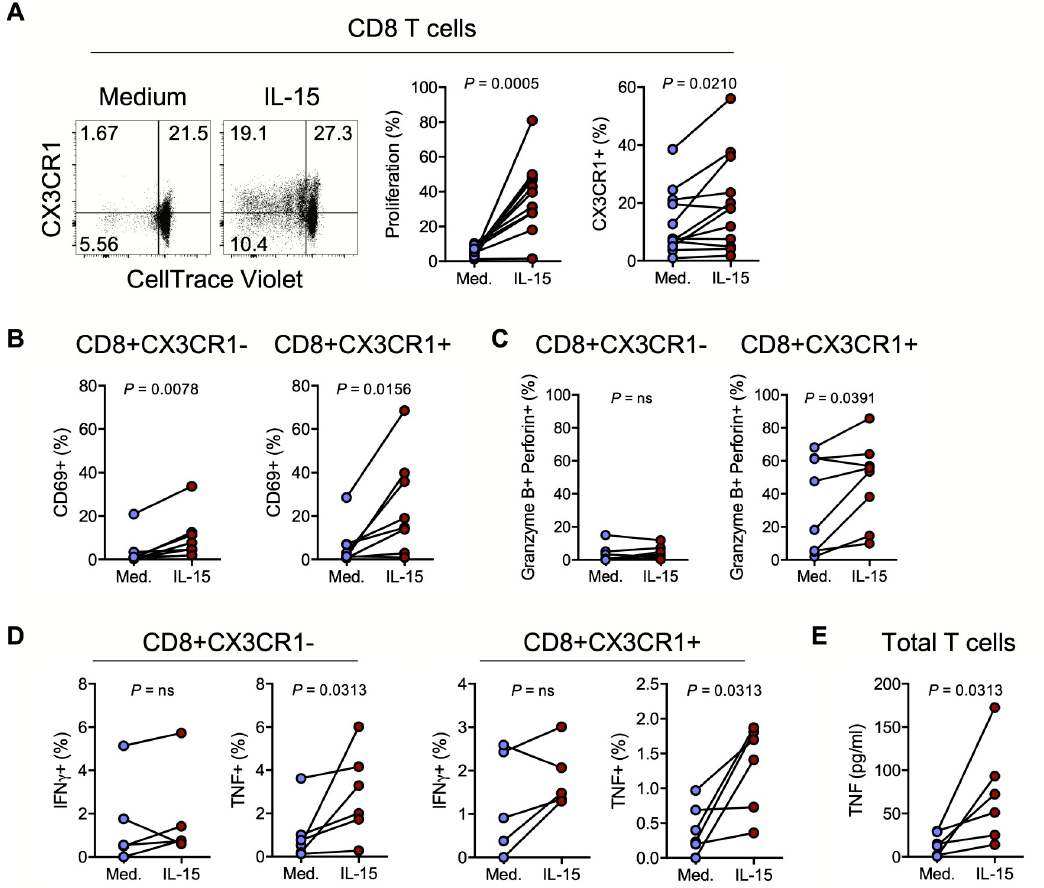
Fig 4. IL-15 drives CD8 T cell proliferation, activation, and an inflammatory, vascular homing, cytolytic phenotype. (A) Representative dotplots (n = 12) showing CX3CR1 and CellTrace Violet expression on CD8 T cells following exposure to IL-15 (20ng/ml) or medium control for 7 days (left), and summary data of proliferation (middle) and surface CX3CR1 expression (right). (B) Proportion of CX3CR1- CD8 T cells (left) and CX3CR1+ CD8 T cells (right) that express surface CD69 after 48h exposure to IL-15 or medium control (n = 8). (C) Proportion of CX3CR1- CD8 T cells (left) and CX3CR1+ CD8 T cells (right) that exhibit intracellular granzyme B and perforin co-expression after 48h exposure to IL-15 or medium control (n = 8). (D) Proportion of CX3CR1- CD8 T cells (left) or CX3CR1+ CD8 T cells (right) that express intracellular IFN γ (n = 5) and TNF (n = 6) following overnight exposure to IL-15 or medium control. (E) Purified T cell (n = 6) TNF production following 48h exposure to IL-15 or medium control as measured by ELISA. Differences between groups were determined by Wilcoxon rank sum test. Med., medium.